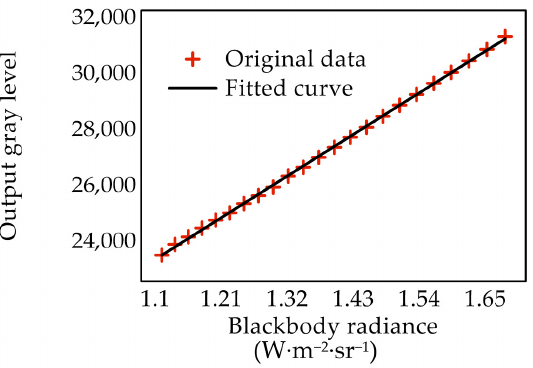
Figure 2. Calibration curve of thermal imager output and blackbody radiance.